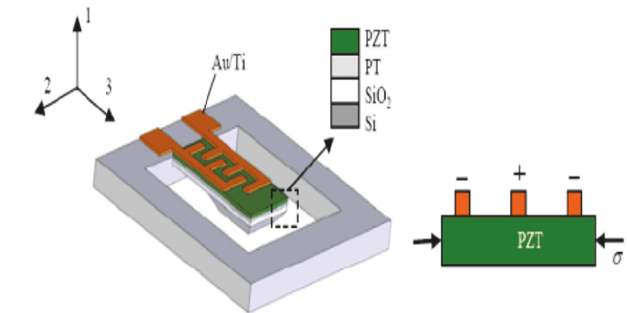
Figure 3: Accelerometer diagram using mode 33 in piezoelectric effect